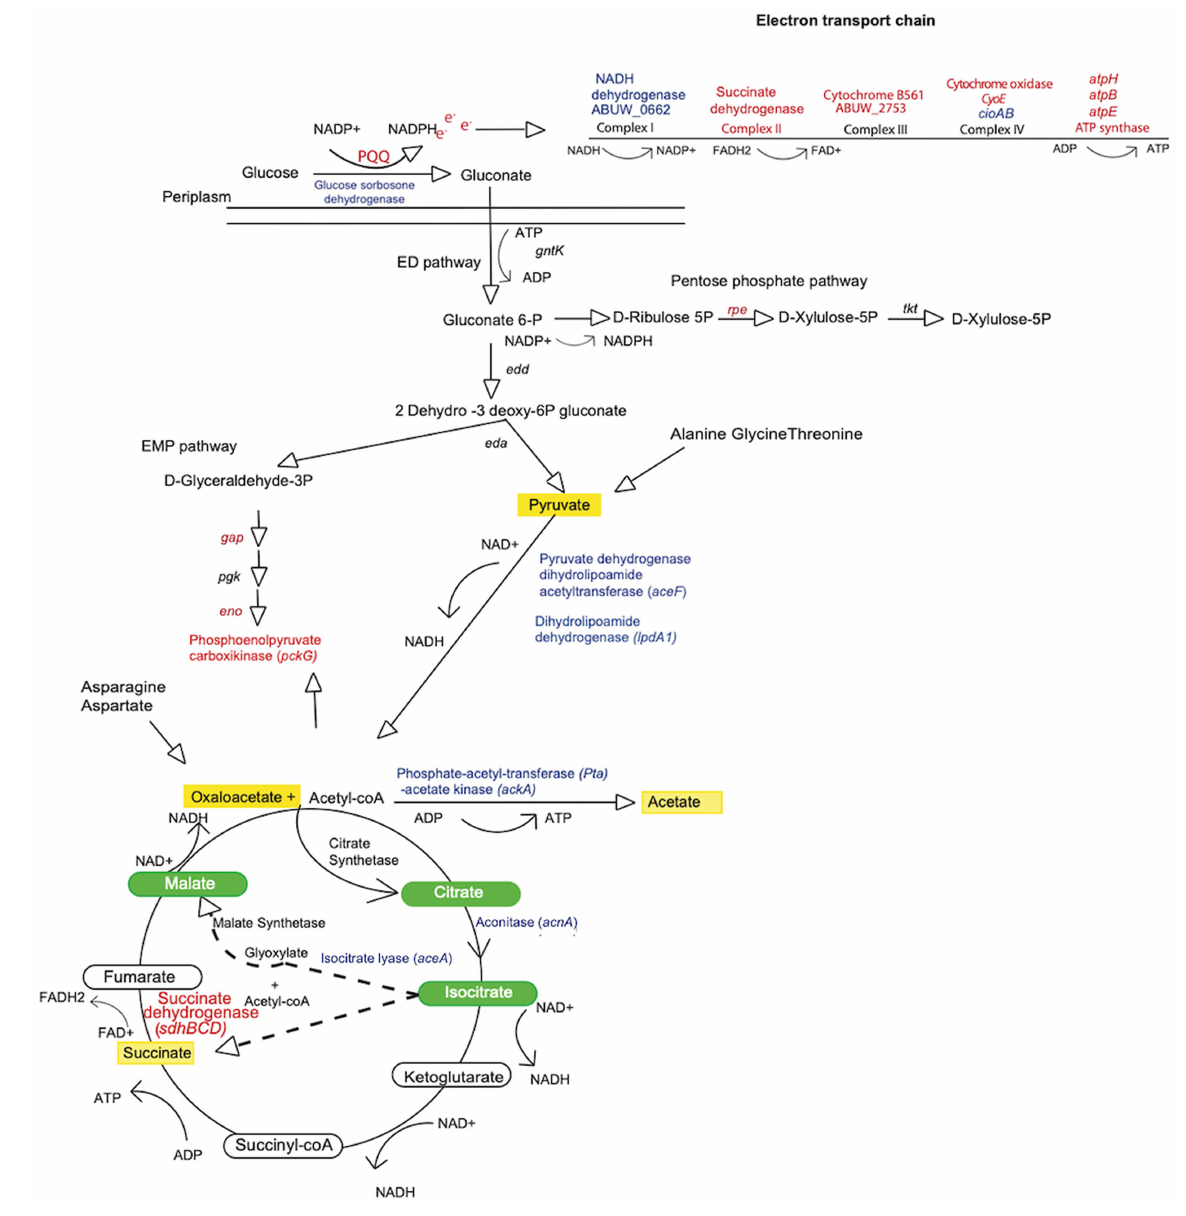
FIGURE 5 Metabolic map for Acinetobacter baumannii indicating nodes of change in the amsR mutant. Shown is a metabolic map for A. baumannii depicting genes with altered expression from Figure 4A. Blue font indicates genes upregulated in the mutant, while red indicates genes that are downregulated. Green ovals indicate metabolites of the glyoxylate pathway. Dashed arrows indicate the two products (glyoxylate and succinate) formed from isocitrate conversion through the glyoxylate shunt. Yellow shading indicates metabolites that accumulate in the amsR −